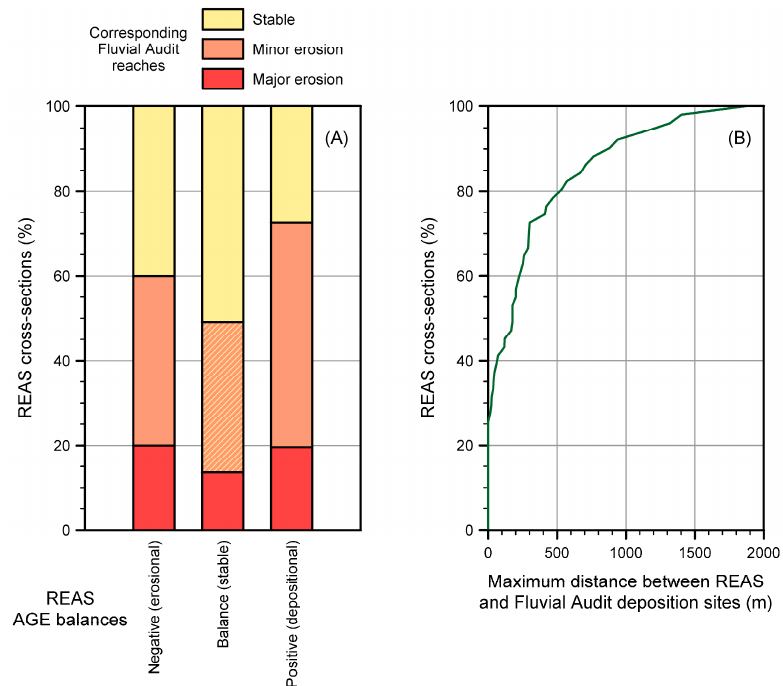
Figure 3. ( A ) Comparison between REAS (River Energy Audit Scheme) Annual Geomorphic Energy (AGE) balances and corresponding Fluvial Audit reaches in the River Kent drainage basin, UK (refer also to Figure 1). As there are no Fluvial Audit reaches classified as entirely depositional, positive AGE balances lie within either stable or erosional reaches [188]. The Fluvial Audit reaches classified as minor erosion that correspond to stable REAS locations (hatched) conceivably refer to sites with generally stable bed and banks but with a degree of erosion along the banklines associated with washout between trees and cattle poaching and are thus unlikely to be indicative of system-wide instability; ( B ) Proximity of REAS sites with positive balances (depositional) to areas of deposition mapped in the Fluvial Audit.